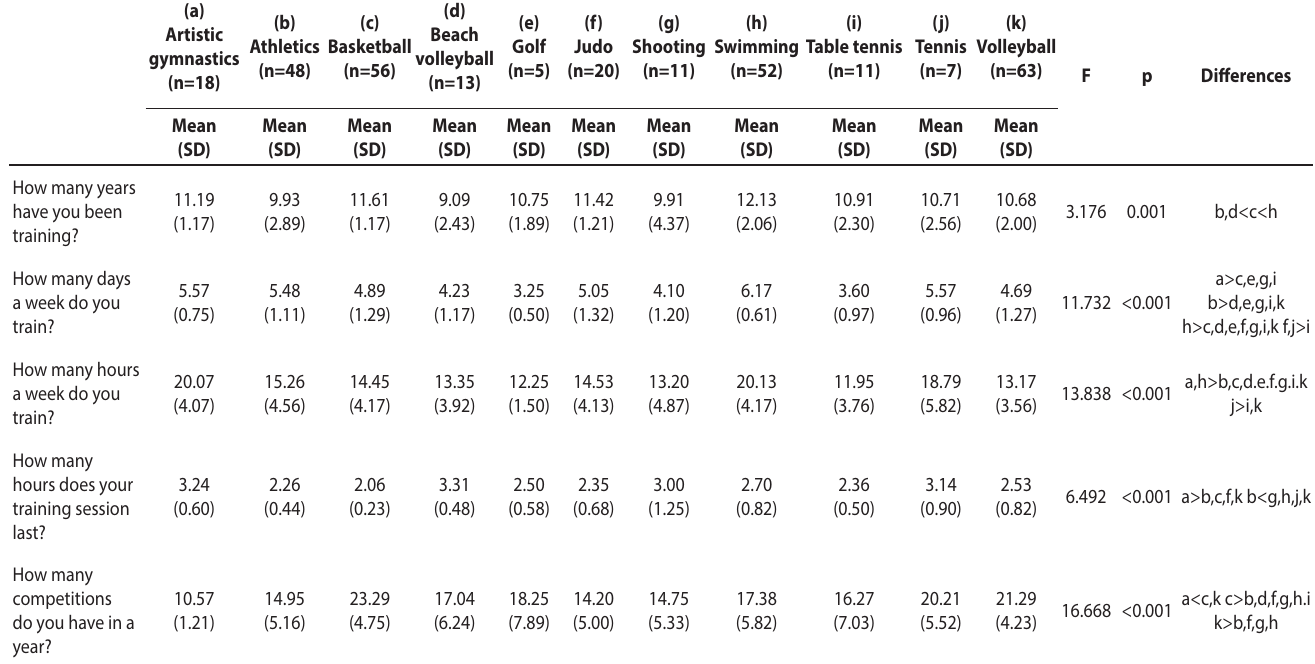
TABLE 3 Means and standard deviations of responses to training volume questions, and one-way ANOVA with Bonferroni post hoc test as a function of the